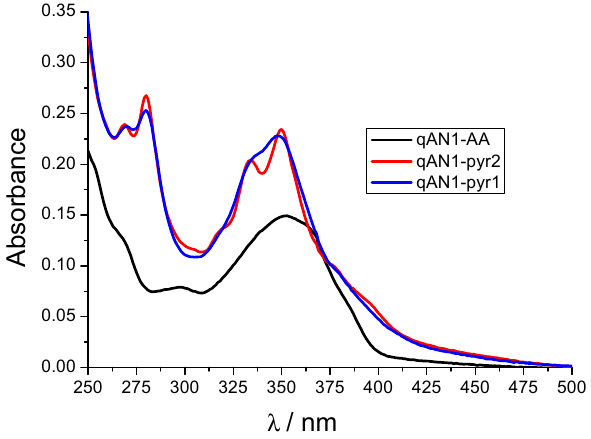
Figure 1. UV/Vis spectra of qAN1-AA and pyrene conjugates qAN1-pyr1 and qAN1-pyr2 ( c = 2 × 10 − 5 M) in sodium cacodylate buffer (pH 7.0, I = 0.05 M) at room temperature.